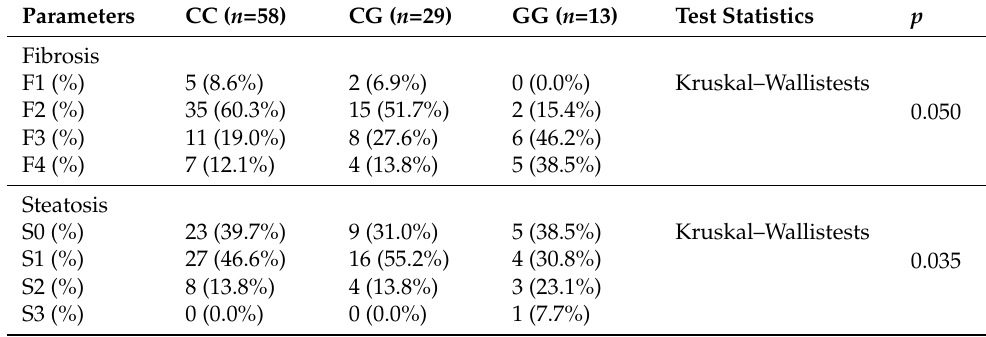
Table 6. Post-treatment fibrosis and steatosis according to PNPLA3 genotype three months